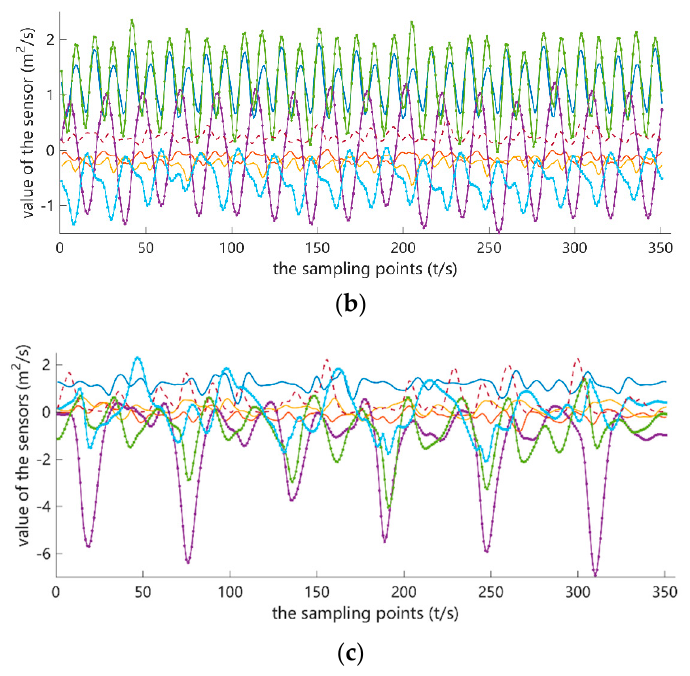
Figure 3. The sensors data flow wave charts of the IMU obtained, ( a ) the wave chart of the sedentary activity; ( b ) the wave chart of the TM6.0; ( c ) the wave chart of the basketball.